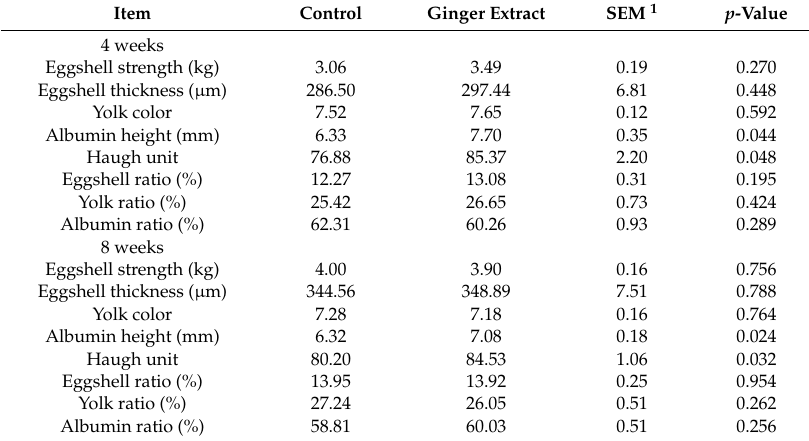
Table 3. E ff ects of ginger extract on egg quality of laying